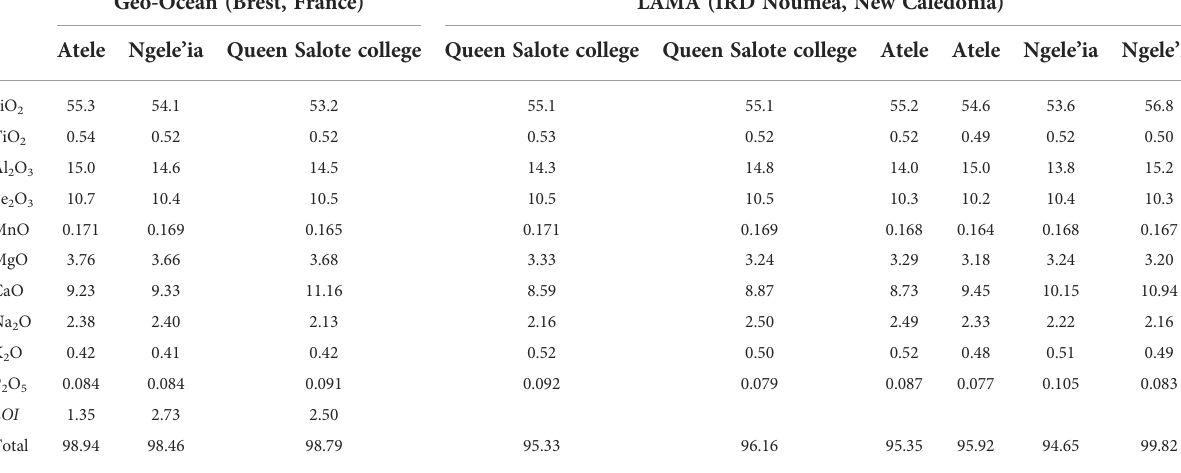
TABLE 3 Chemistry of ash samples (in wt%) collected on Tongatapu island after the 15 January 2022 eruption. Geo-Ocean (Brest, France)